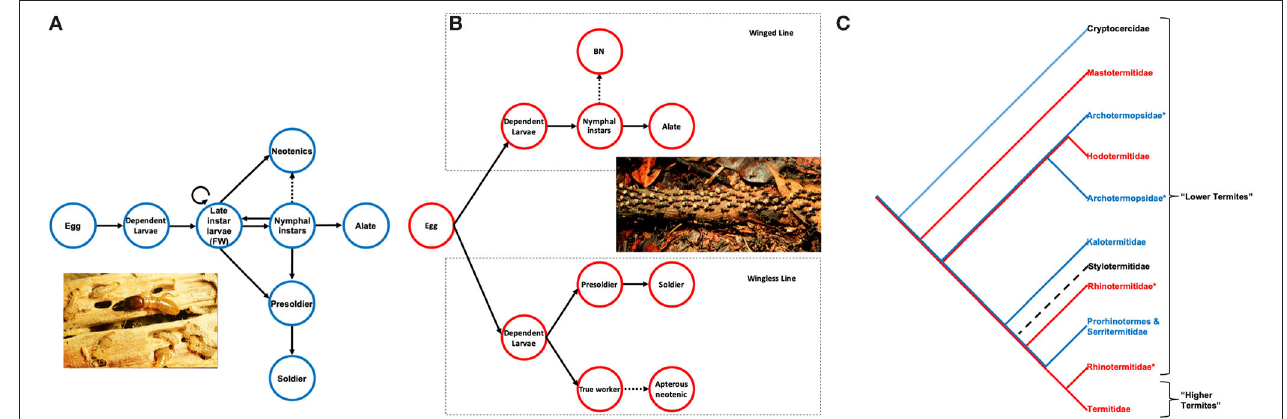
FIGURE 1 | Simplified developmental pathway of (A) wood nesting termites and (B) foraging termites. Solid forward arrows, progressive molts; solid backward arrows, regressive molts; dashed arrows, potential progressive molts in some species; circular arrow, stationary molt; BN, Brachypterous neotenics. Modified after ( Korb and Hartfelder, 2008). (C) Phylogenetic relationships of termite families (cladogram) using the sister taxon Cryptoceridae as outgroup, highlighting the phylogenetic uncertainty of life types and ambiguity surrounding which came first in evolutionary terms. Blue, Wood-dwelling termite species; Red, Foraging termite species; Black dashed, not enough is known about this family to definitively categorize but they are likely to be wood-dwelling species, *signifies paraphyletic families. Modified after (Korb, 2019), ( See Box 1 for definitions ). [photos by Bill Sands, NHM London collection : (A) Zootermopsis (B) Hospitalitermes